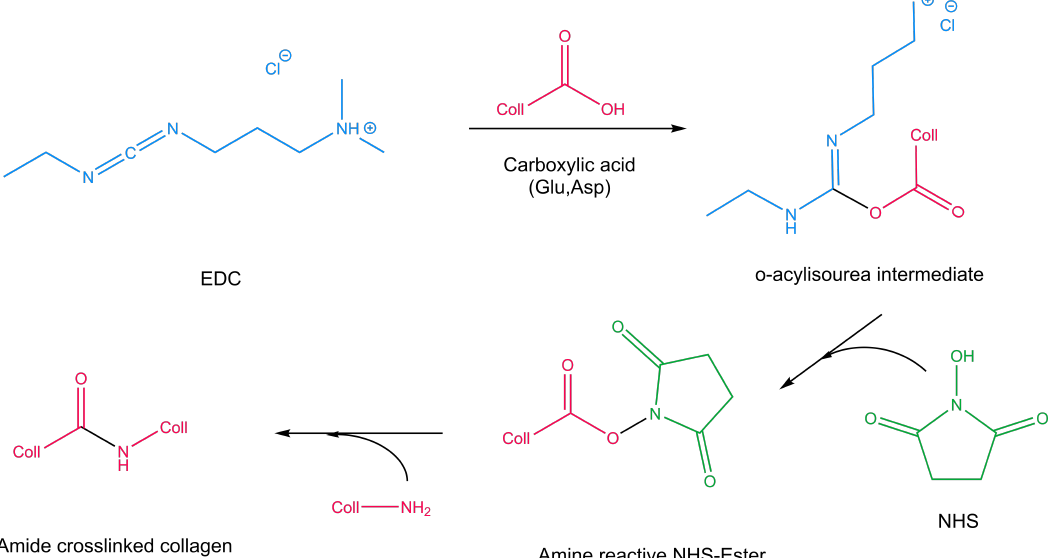
Figure 2. Crosslinking mechanism of EDC-NHS. Illustration redrawn from proposed mechanisms